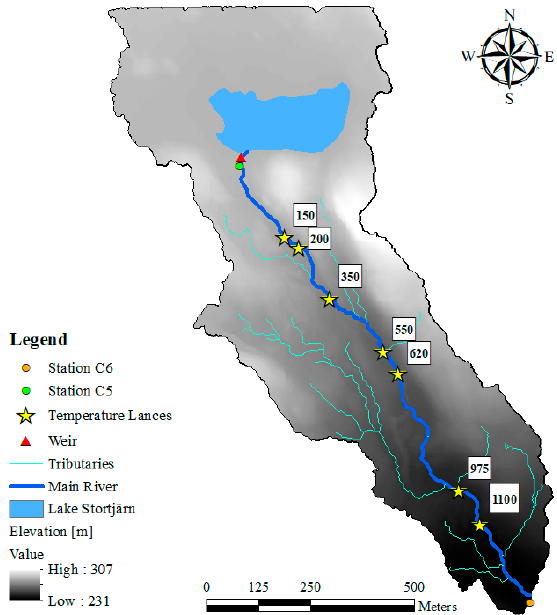
Figure 1. Map showingthe experimental subcatchment andits topography, the main river(dark blue color), tributaries (cyan color), Lake Stortjärn (solid light blue region), and hydrological stations C5 and C6. Also shown are the locations of the V-notch weir (red flag) and temperature lances (yellow